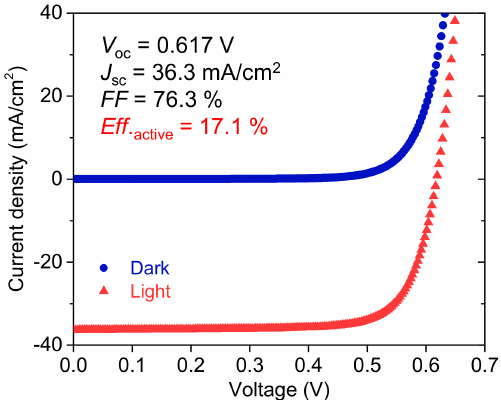
Figure 10. J - V characteristics of the CIGS solar cell prepared by the three-stage